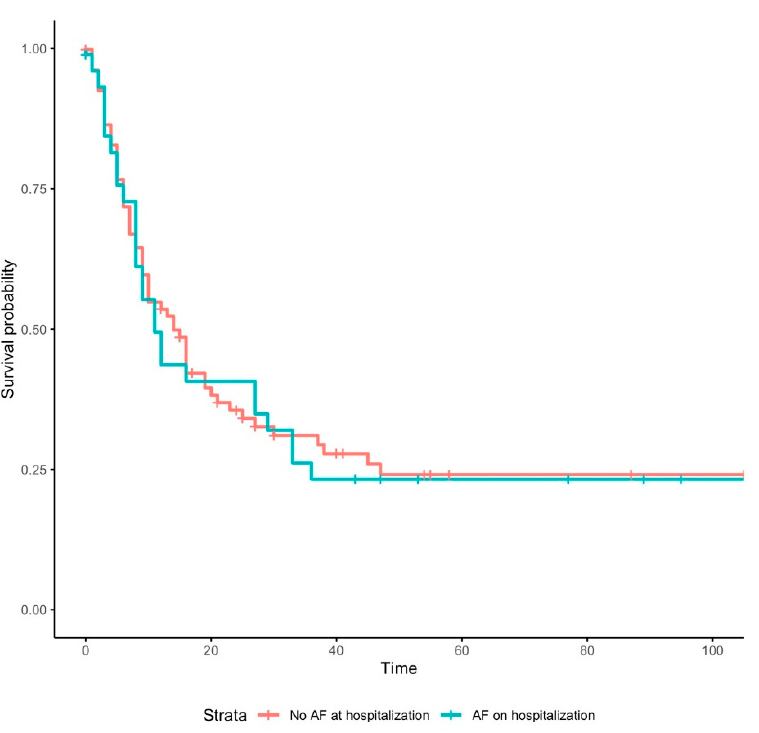
Figure 5. Kaplan–Meier survival curve for “In-Hospital Death” in patients with COVID-19 with and without atrial fibrillation. Abbreviations: AF = atrial fibrillation.